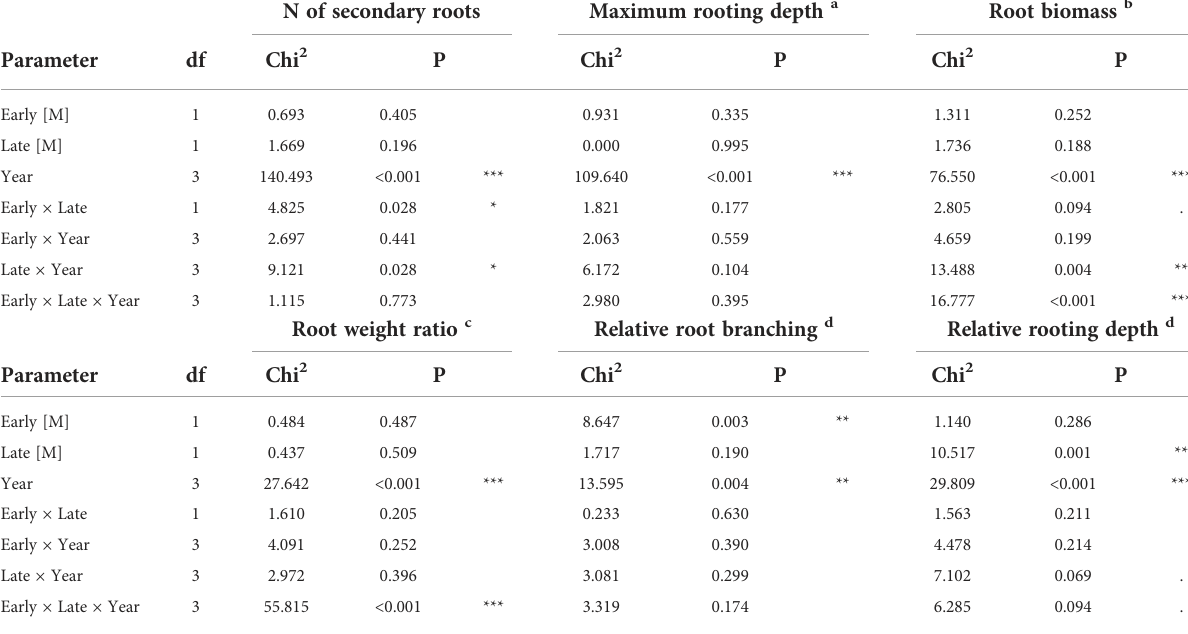
TABLE 1 Precipitation predictability treatment effects on root traits of